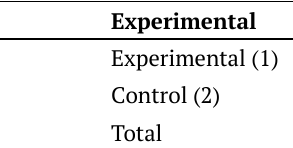
Table 1. The research sample for the two experimental groups Variable Total number Group Experimental 10 First Experimental The forehand and backhand tennis skills